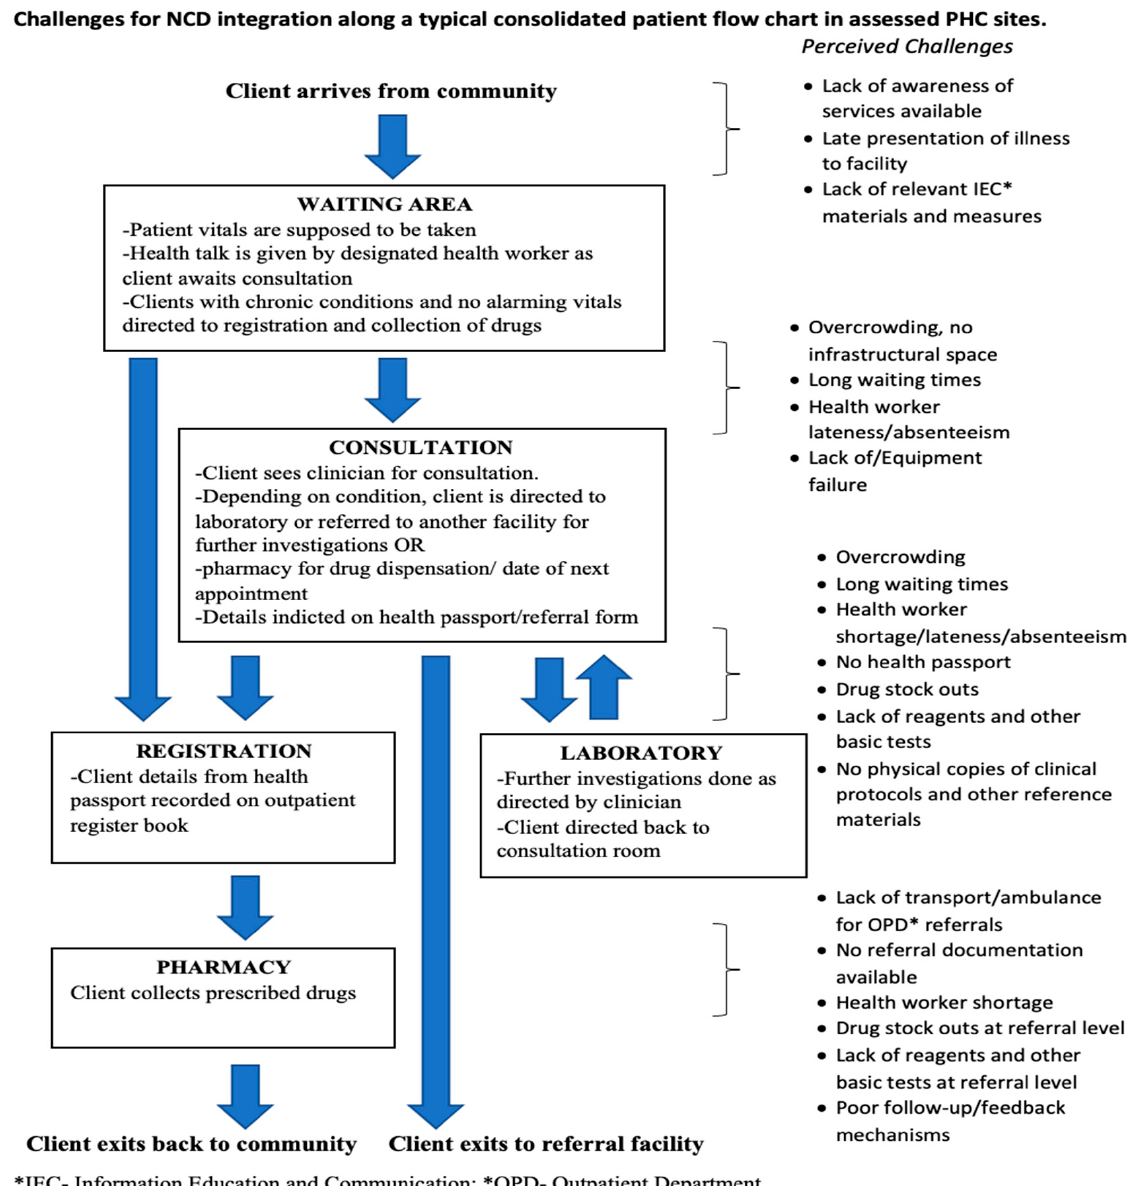
Figure 5. Description of operational challenges for NCD integration along a typical consolidated patient flow in assessed PHC sites.